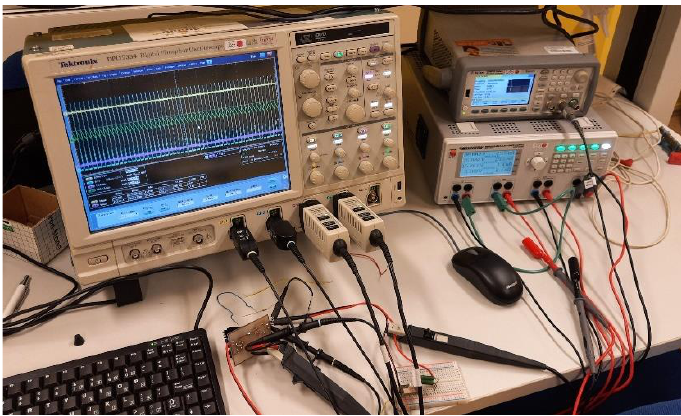
Figure 12. The experimental measurement of the LM2576HV DC – DC converter.